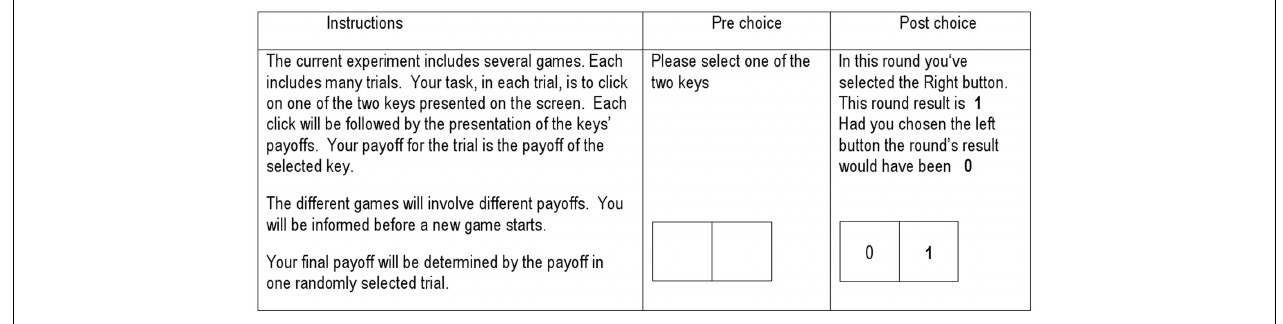
FIGURE 1 |The instructions, and the screens in a study that uses the basic clicking paradigm. In the example the participant chose Right, won 1; and the forgone payoff was 0.The exact payoffs were determined by the game’s payoff rule. Each of the games considered here focused on one of